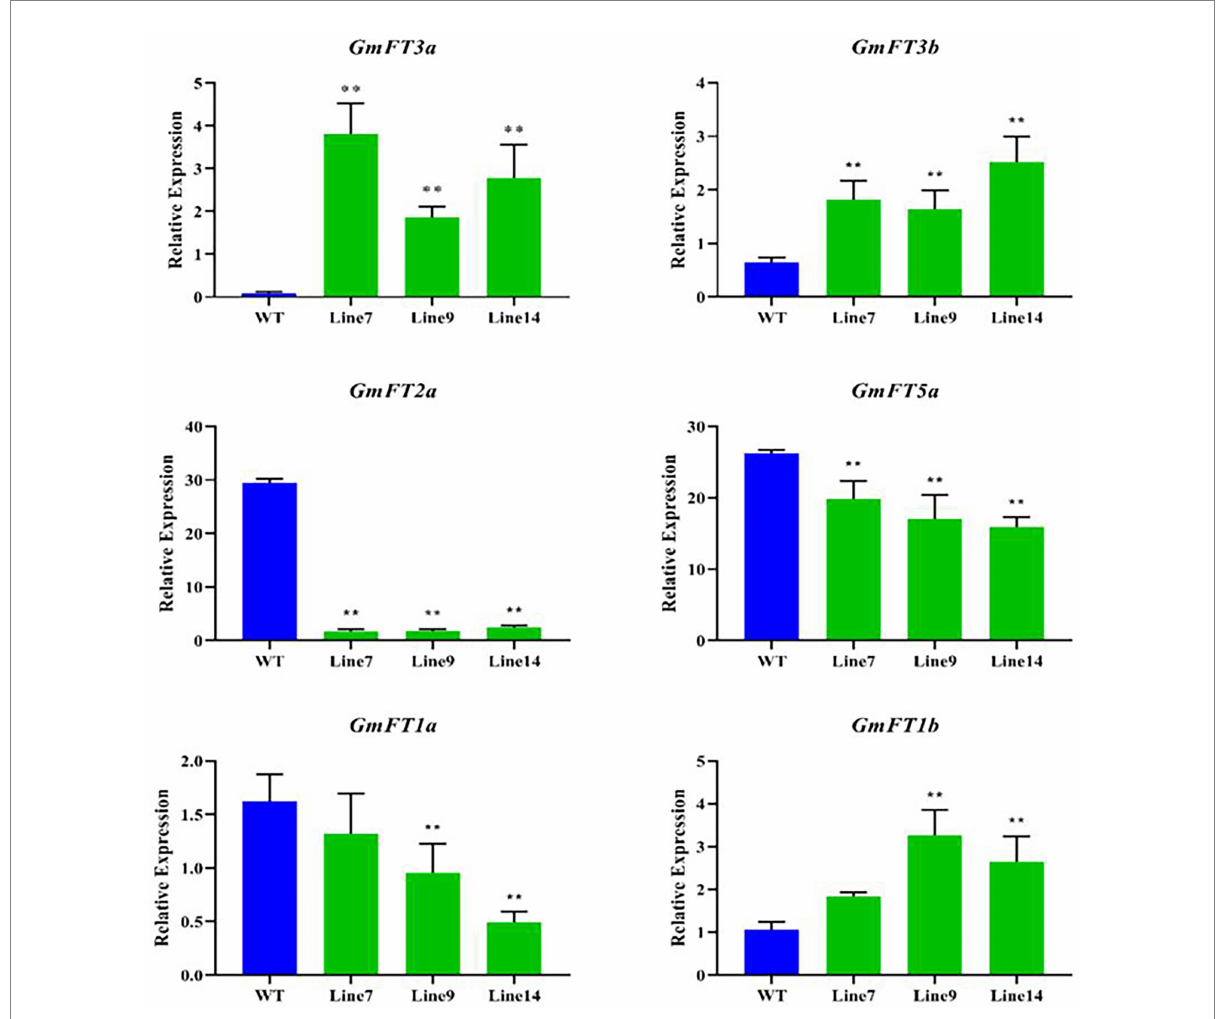
FIGURE 4 Expression analysis of GmFT3a in transgenic plants in LD